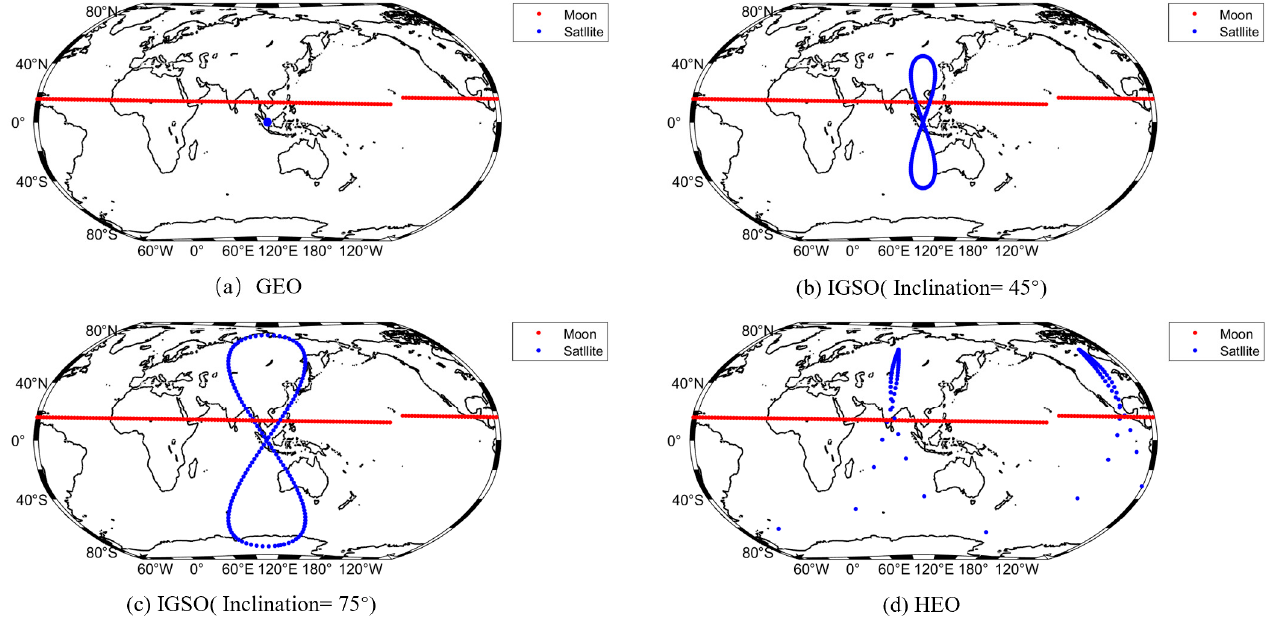
Figure 9. Nadir track of satellites with variant orbital parameters and Moon-based observatory in one day . one